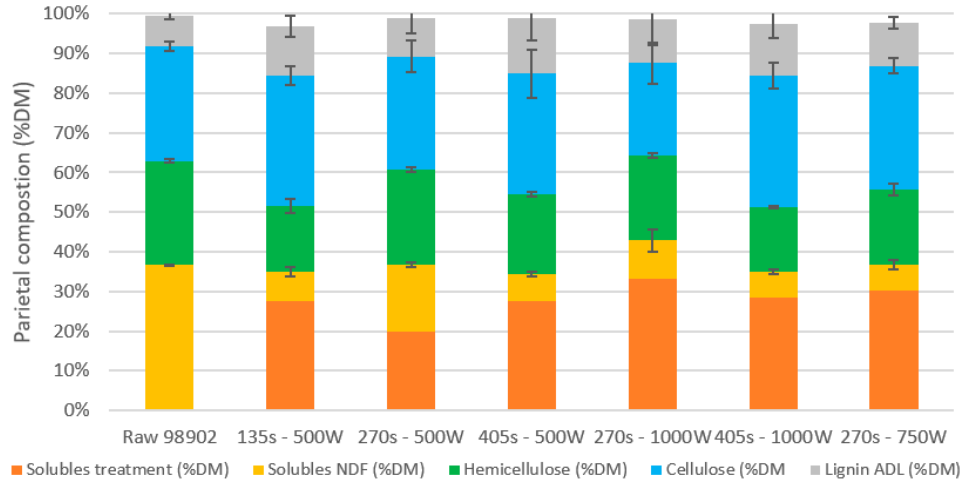
Figure 7. Pretreated biomass composition after RSM plan (mean of duplicate analysis).